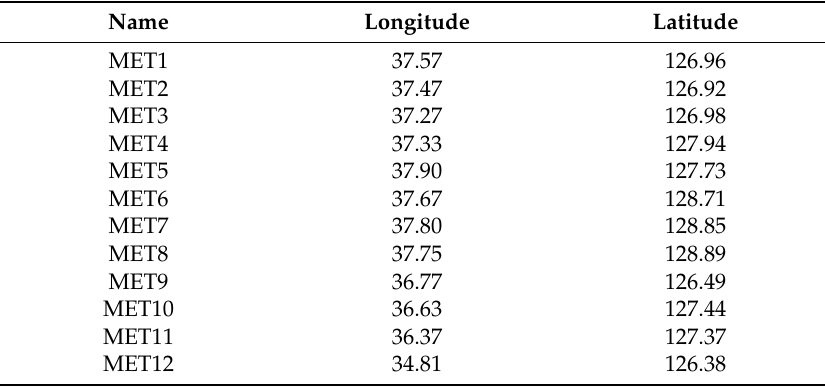
Figure 4. Location data of both 30 METs and the solar farm. Table 1. Location data of both 30 METs and the solar farm.